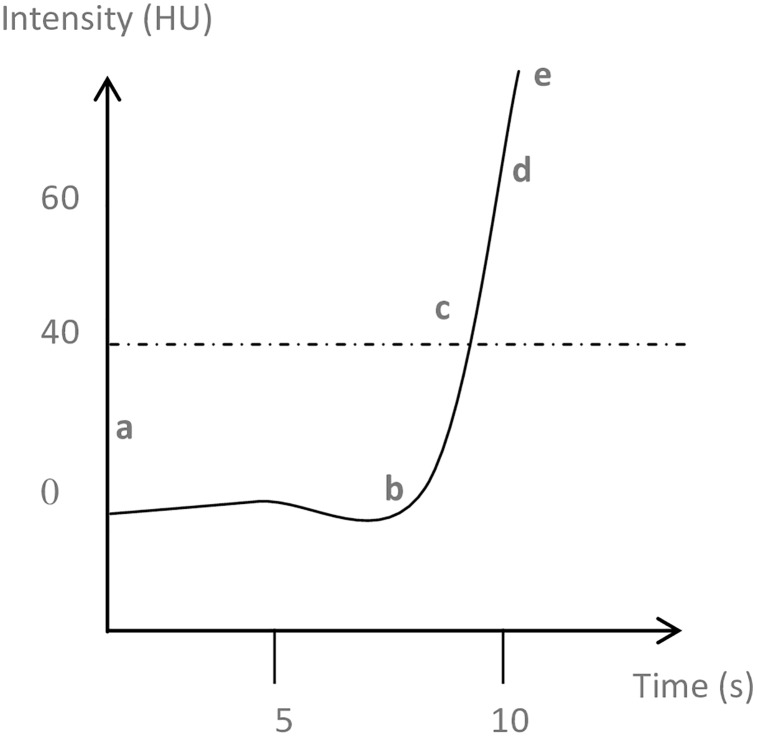
Schematic time-intensity curve given by the bolus tracking system.From the injection of contrast into the peripheral vein (point a), until the contrast media reaches the pulmonary artery (b), the curve is flat. After the inflection point (b), there is a brisk rise in intensity measured by the system, and the intensity reaches a predefined threshold to start the sequence of data acquisition (40UH, point (c)). The intensity slope is calculated by subtracting the intensity measured at the inflection point (b) to the highest intensity measured (e) divided by the time between those two points. The point (d) is the intensity reached at 10 seconds. ROI: region of interest; HU: Hounsfield units; s: seconds.